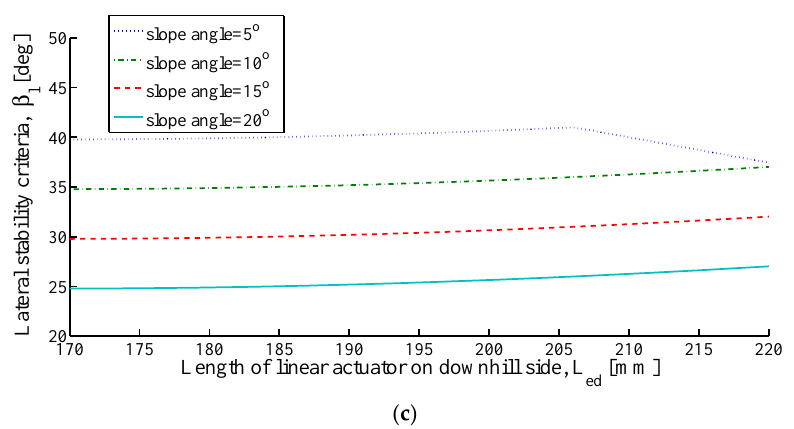
Figure 11. Lateral stability with expending the downhill side actuator: ( a ) Adjustable angle; ( b ) Roll angle; ( c ) Lateral stability criteria.